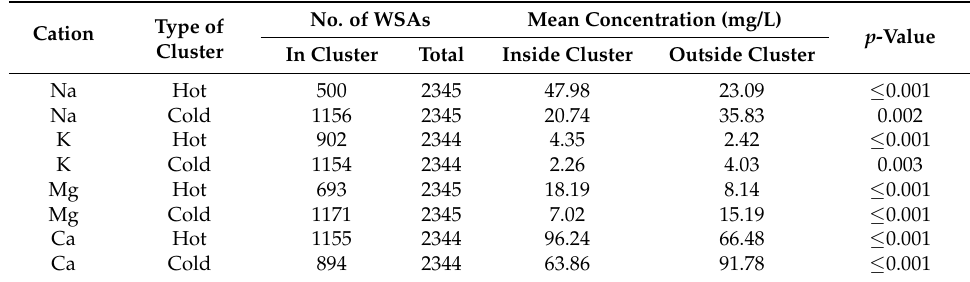
Table 2. Statistical significant clusters ( p ≤ 0.05) of high (hot spot) and low concentrations (cold spot) of Na, K, Mg and Ca in drinking water. Up to 50% of the data points were included in the clusters,